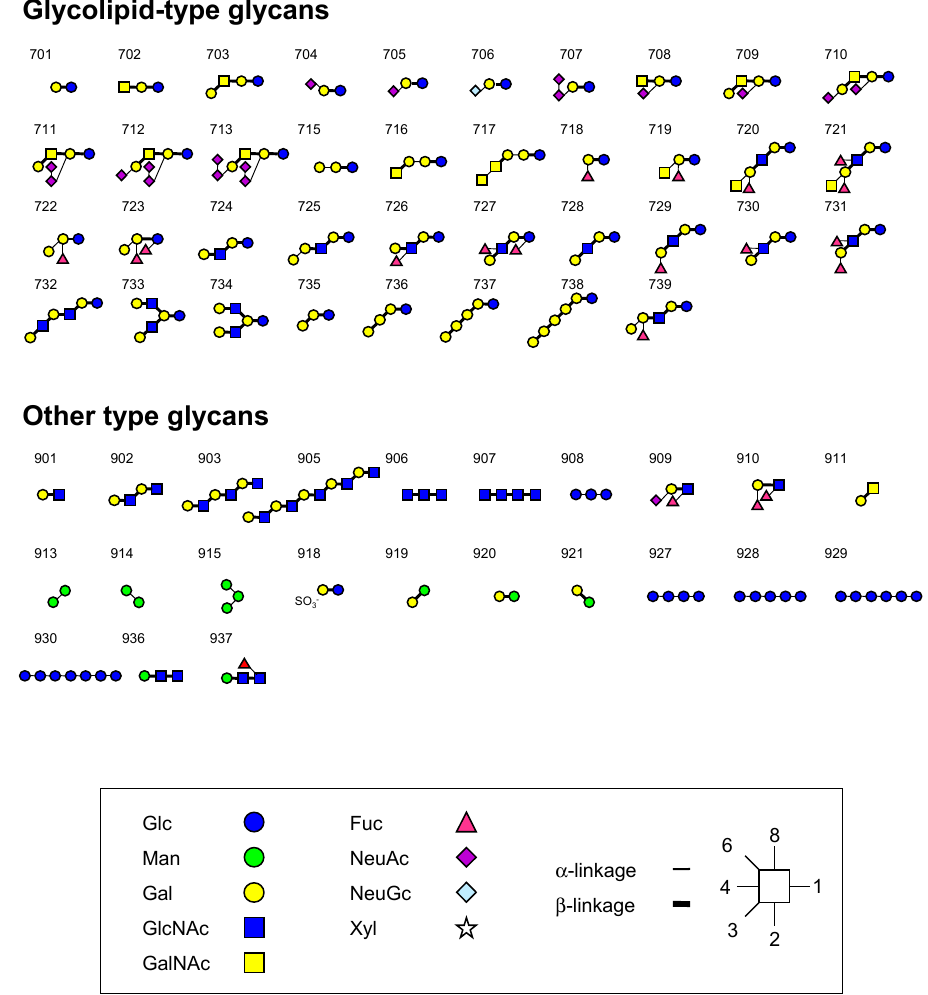
Figure 3. A list of PA-oligosaccharide structures used in this work. Note that the reducing terminal of each PA-oligosaccharide is in an open form because of monoamine coupling with 2-aminopyridine. Carbohydrate structures are expressed using symbols according to the rules defined by the Consortium for Glycomics (CFG; http://www.functionalglycomics.org/static/consortium/Nomenclature.shtml) with further modification to specify linkage and anomeric types: position 1, is placed at the right side, and numbering proceeds clockwise. Thin and thick bars represent α - and β -linkages, respectively.